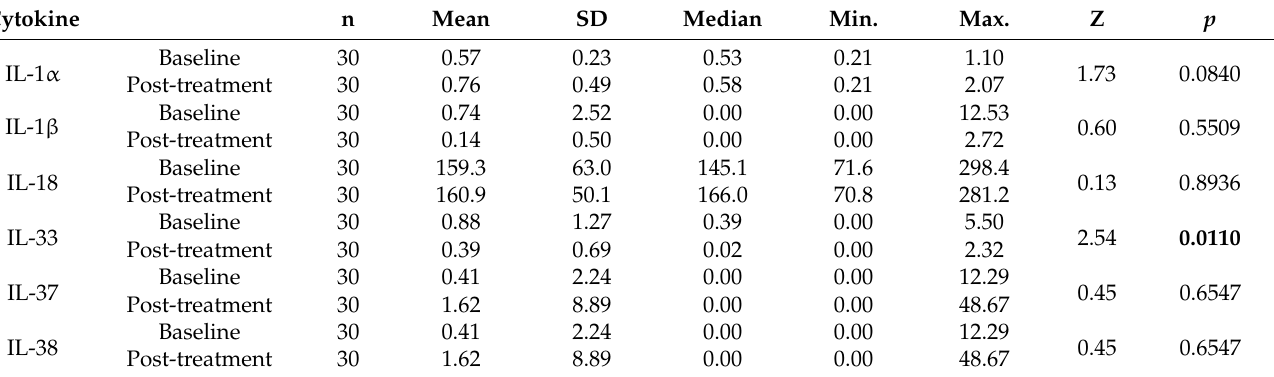
Table 6. Changes in cytokines concentrations in patients with LoS before (baseline) and after treatment.